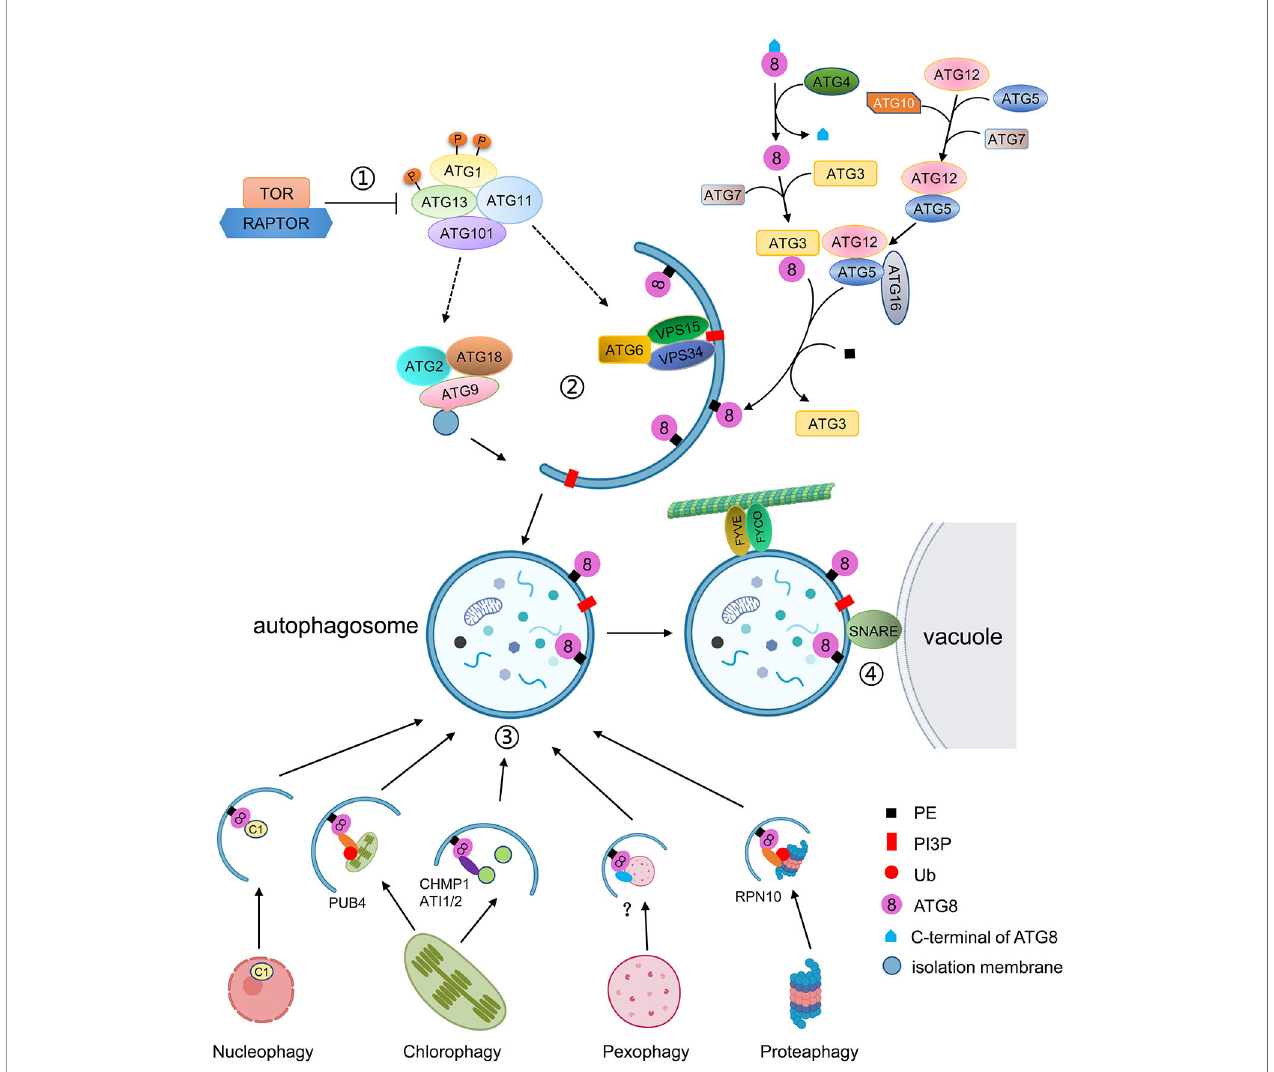
FIGURE 1 | Schematic diagram of the autophagy process. ① Autophagy is regulated by TOR kinase. Inhibition of TOR results in activation of constitutive autophagy, while overexpression of TOR blocks autophagy. Autophagy is initiated by the association of ATG13 and ATG1, together with ATG11 and ATG101, into an active complex. ② Autophagosome formation includes membrane delivery, vesicle nucleation and phagophore expansion and closure. ATG9, with ATG2 and ATG18, is involved in the delivery of lipids to the expanding phagophore. The VPS34 lipid kinase complex generates PI3P decoration, which is accompanied by the conjugation of ATG8 to PE. ATG8 fi rstly is matured by cleavage of its C-terminal by ATG4, and then is conjugated to PE by E2-like ATG3 and the E3-like ATG12-ATG5-ATG16 complex. ATG8-PE localizes to the autophagosomal membrane for phagophore expansion. ③ Selective autophagy is mediated by interaction of ATG8 with speci fi c autophagic receptors through the AIM domain. Different cell components can be recognized by speci fi c autophagic receptors. For instance, the C1 protein is translocated from the nucleus to the cytoplasm and binds to ATG8 for degradation. The whole chloroplast is ubiquitulated by PUB4 and binds to ATG8. The fragments of chloroplasts are recognized by CHMO1 or ATI1/2 for degradation by RCBs or ATI1/2 decorated plastid bodies. In plants, peroxisomes to be degraded are probably recognized by PEX6 or PEX10, and the ubiquitylated proteasome is recognized by RPN10. ④ The mature autophagosome is transported to the vacuole with the help of FYVE and FYCO proteins and fused with the vacuole to be